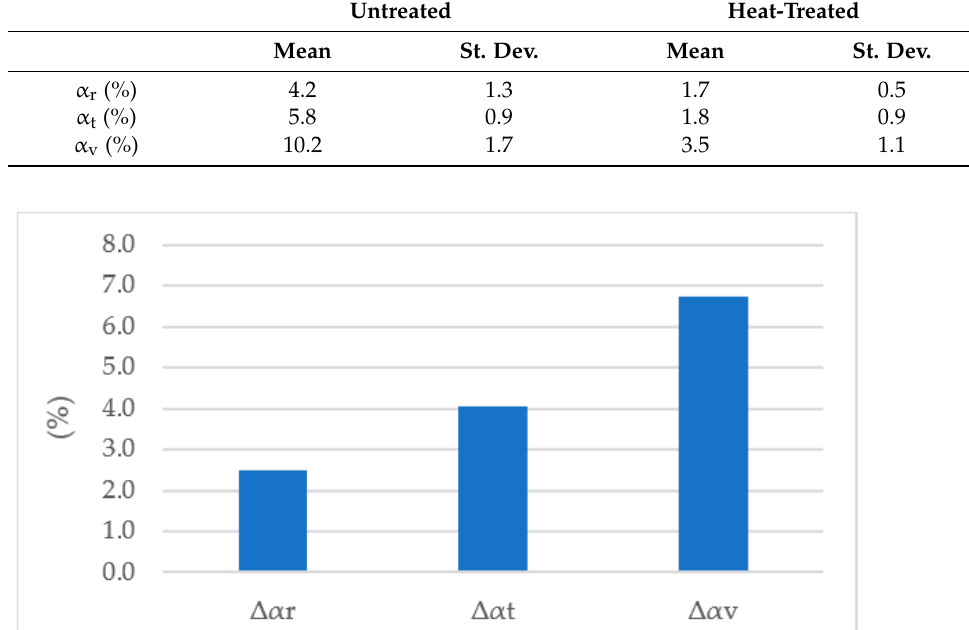
Table 1. Linear and volumetric swelling of untreated and heat-treated ayous wood. Untreated Heat-Treated Mean